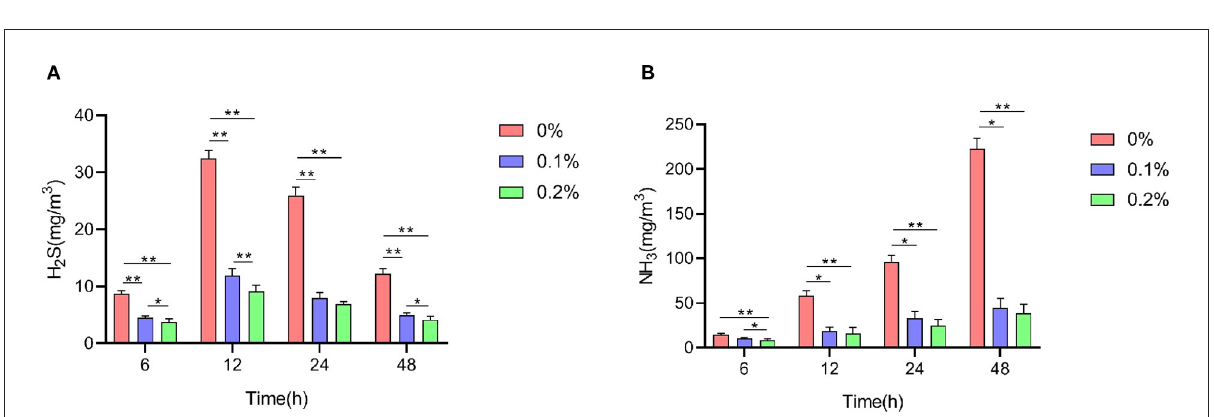
FIGURE4 Effect of PC addition to diets on the noxious fecal gas emission in AA + broilers. (A) H 2 S (B) NH 3 . “*” means indicates a significant difference ( P < 0.05). “**” means indicates a extremely significant difference ( P < 0.01). No “*” indicates that the difference is not significant ( P > 0.05).